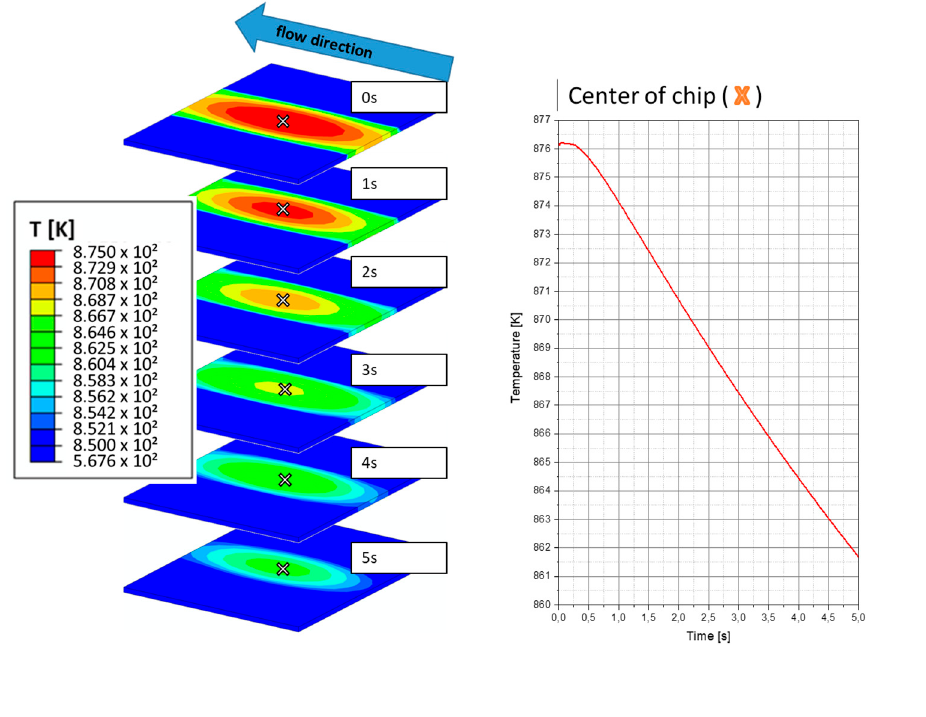
Figure 4. Results from a combined CFD and heat transfer simulation. An arc indicates the flow direction. A gas flow of 5 m/s was chosen. In the center of the chip the temperature drops from 600 °C to 584